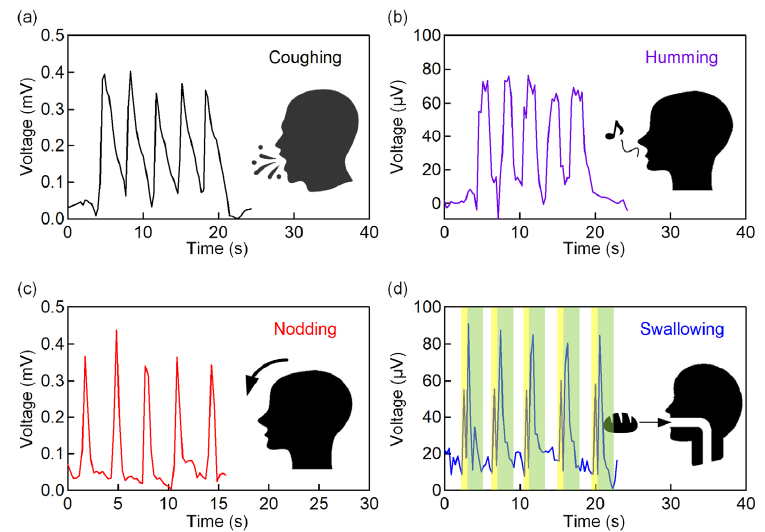
Figure 5. Measured output voltages from the IPMC sensor for ( a ) coughing, ( b ) humming, ( c ) nodding, and ( d ) swallowing actions.